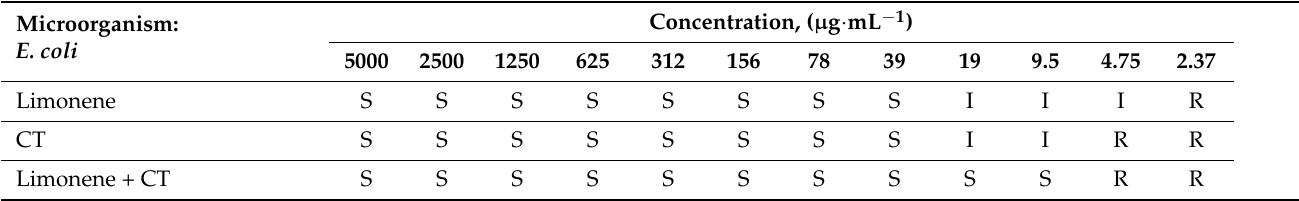
Table 3. Susceptibility of E. coli at different treatments.